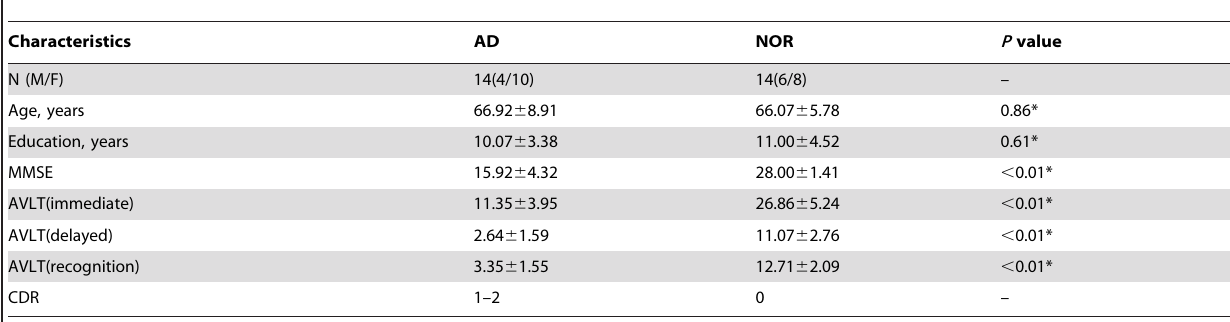
Table 1. Characteristics of the AD patients and Normal controls.